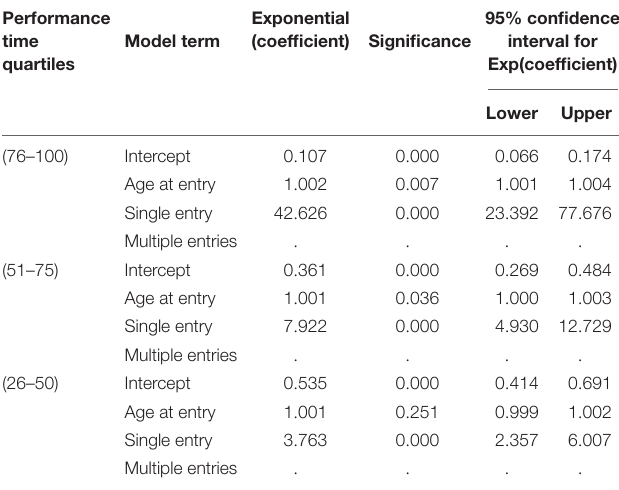
TABLE 4 | Regression of performance time quartiles against age at entry and single or multiple age entries. Performance